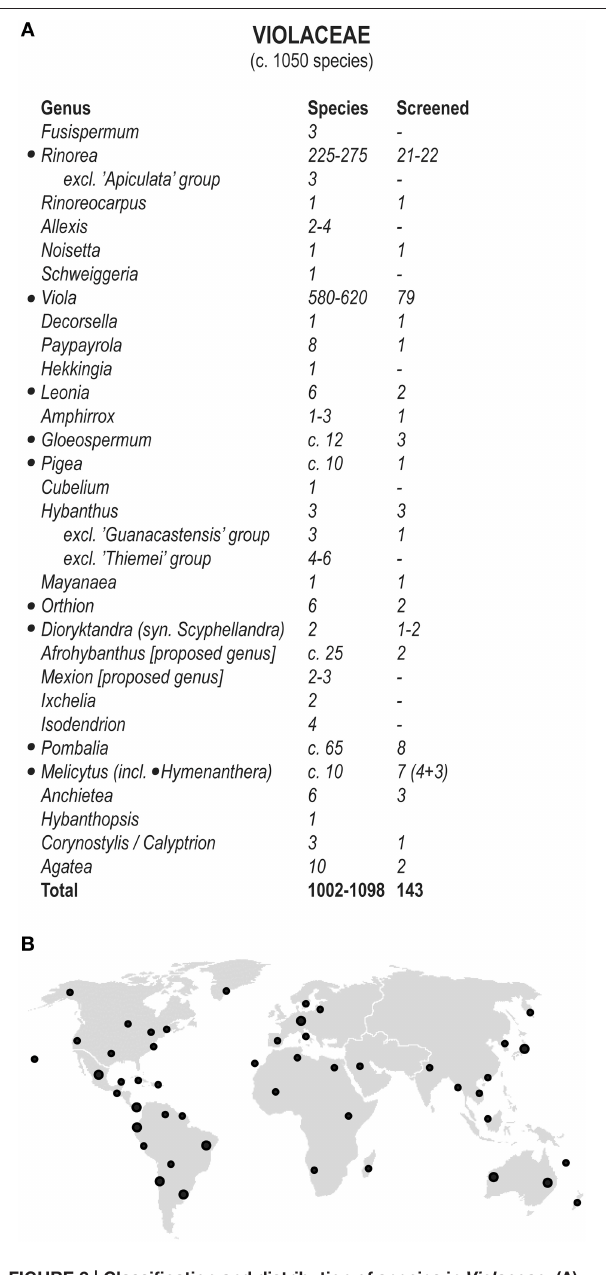
FIGURE 2 | Classification and distribution of species in Violaceae . (A) Classification of Violaceae in accordance with the phylogenetic analysis by Wahlert et al. (2014) with additional taxonomical changes (de Paula-Souza and Ballard, 2014; de Paula-Souza and Pirani, 2014; Wahlert et al., 2015). The number of recognized species positively identified to contain cyclotides is tabulated next to the total number of species. The genera containing isolated cyclotides are indicated by bullet points ( • ). (B) Geographical origins of herbarium specimens sampled for mapping cyclotide diversity and occurrence in the Violaceae. Although the family has a cosmopolitan distribution, nearly all genera are tropical. The only exceptions are species from the genus Viola and the species from the genus Cubelium